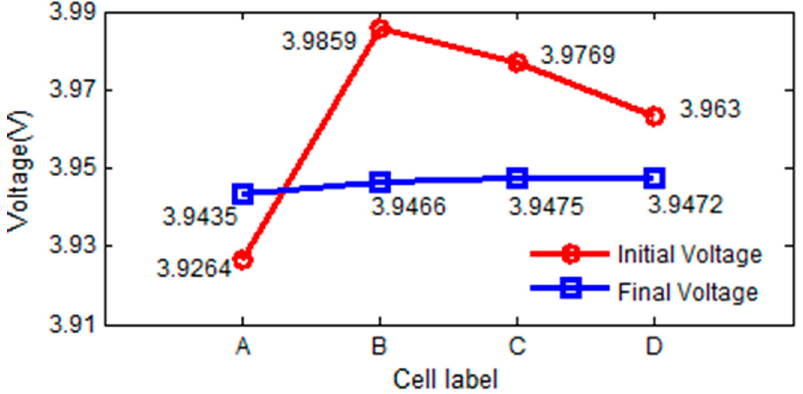
Figure 10. The cells’ voltage waveforms in the equalization process for A, B, C and D ( a ) A. ( b ) B. ( c ) C. ( d ) D.